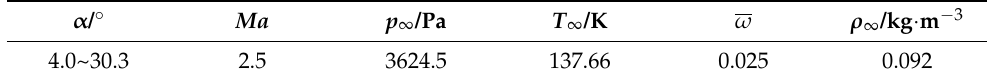
Table 1. Computational conditions for Magnus effect simulation.